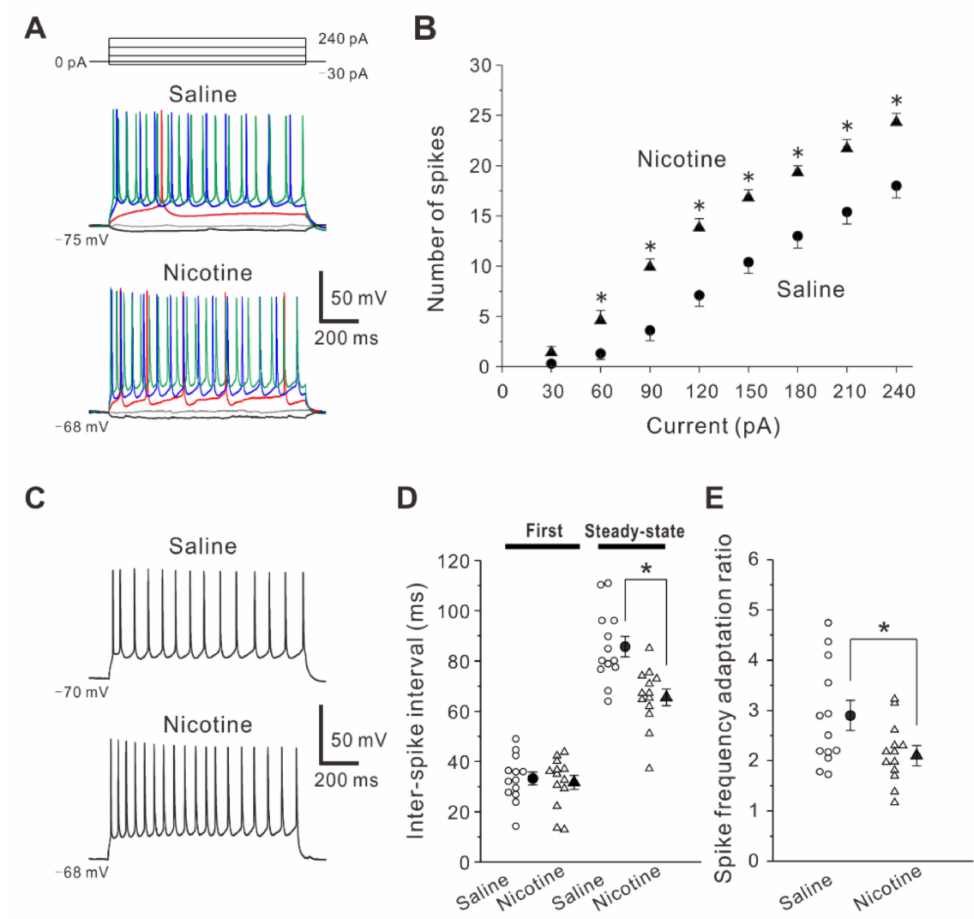
Figure 3. Effects of adolescent nicotine exposure on spiking ability and inter-spike interval. ( A ) Sam- ple traces of voltage responses induced by current pulses obtained from PNs of a saline-treated mouse (top) and a nicotine-treated mouse (bottom). Black, gray, red, blue and green traces represent voltage responses induced by current pulses at the intensities of − 30, 0, 60, 150 and 240 pA, respectively. ( B ) Relationship between current strength and spike number obtained from PNs of saline-treated mice (n = 16 neurons/6 mice) and nicotine-treated mice (n = 16 neurons/7 mice). Two-way repeated measures ANOVA post-hoc LSD, *: p < 0.05 between the two groups. ( C ) Sample traces of voltage responses induced by depolarizing current pulses at the intensity of 180 pA obtained from PNs of a saline-treated mouse (top) and a nicotine-treated mouse (bottom). ( D ) Summary data of first and steady-state inter-spike interval obtained from PNs of saline-treated mice (n = 13 neurons/6 mice) and nicotine-treated mice (n = 13 neurons/7 mice). Unpaired t -test, *: p < 0.001. ( E ) Summary data of spike frequency adaptation ratio obtained from PNs of saline-treated mice (n = 13 neurons/6 mice) and nicotine-treated mice (n = 13 neurons/7 mice). Unpaired t -test, *: p =